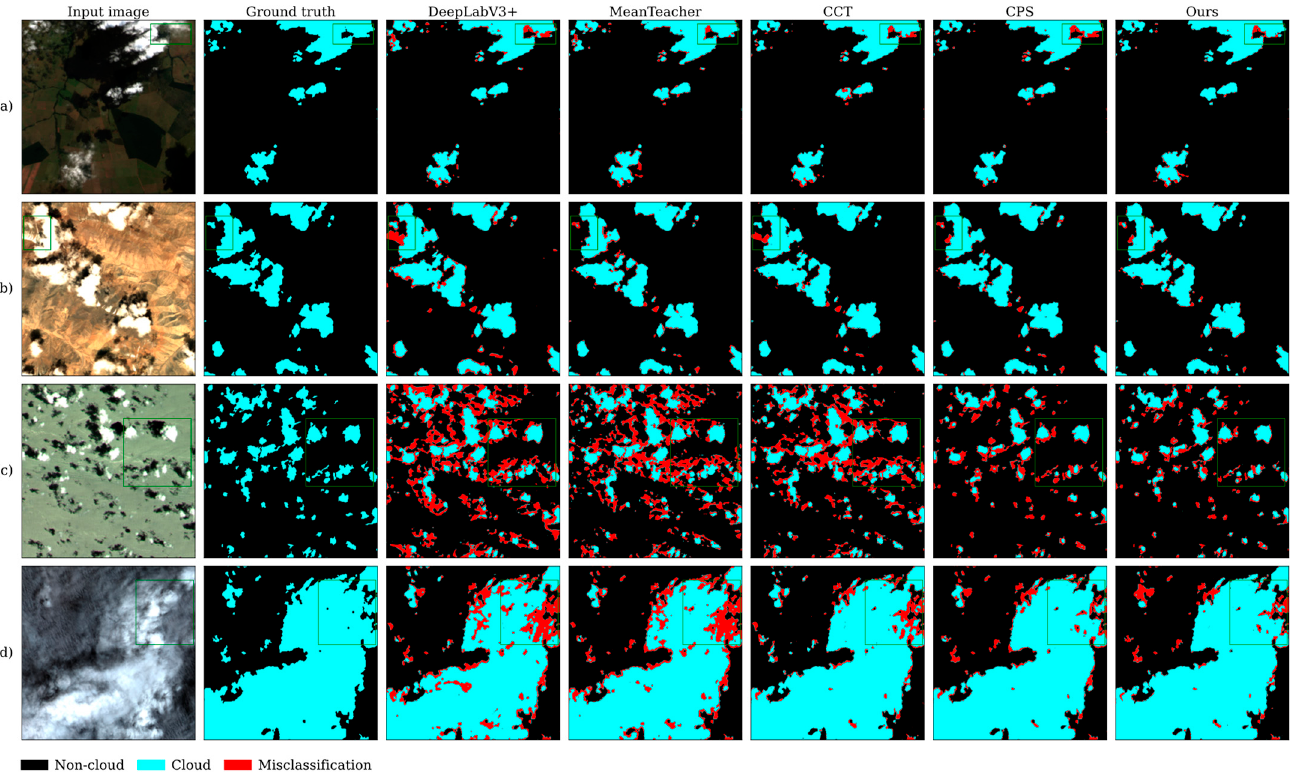
Figure 6. Examples of cloud detection results on the GF1-WHU dataset at a labeled ratio of 1/2.